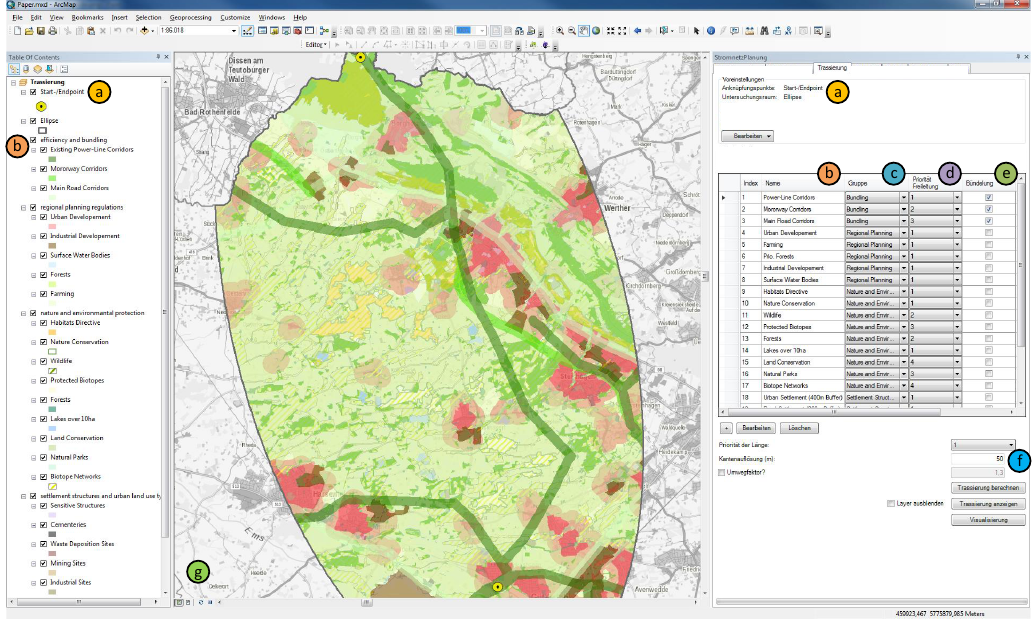
Figure 2. Criteria generation with the developed ArcMap Add-In: a definition of start and end point and study area; b feature layers from the ArcMap data frame added to the list of criteria; c classified in an arbitrary amount of criteria categories (groups); d by defining an priority value for each layer, an inter-group weighting of the criterion is achieved; e criteria with positive impact are flagged as bundling criteria; f definition of the length of graph edges in metres; g visualisation of the criteria layers in the ArcMap map view. Data copyright by GeoBasis-DE/BKG 2017